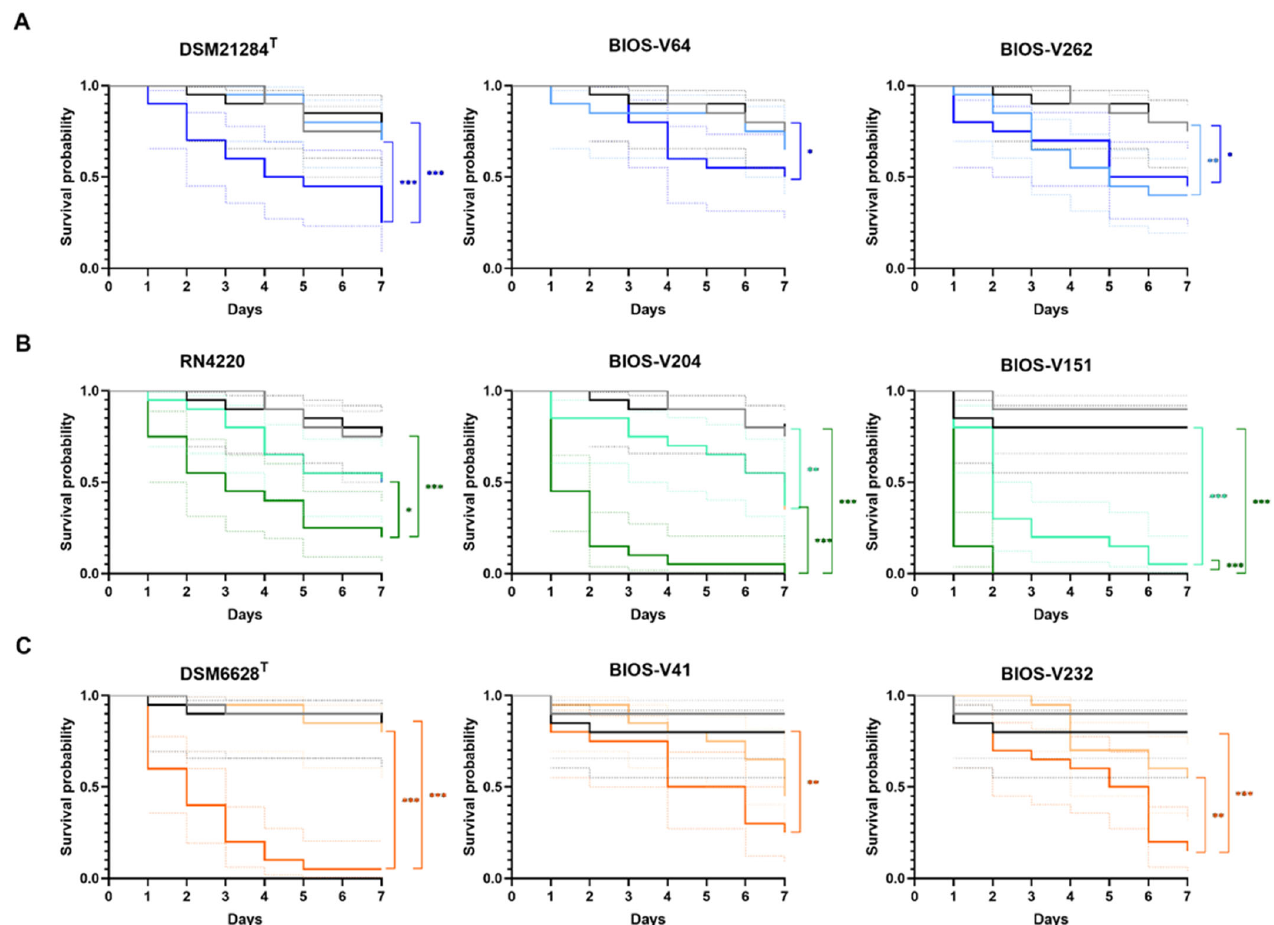
Figure 3. Kaplan–Meier survival analysis of G. mellonella infected with reference strains and biofilm-producing S. pseudintermedius ( A ), S. aureus ( B ) and S. coagulans ( C ) strains representative of the main clonal lineages causing animal pyoderma. Grey line: “no manipulation” control group; black line: “PBS” control group; light colors: 1 × 10 5 CFU/larva; dark colors: 1 × 10 7 CFU/larva. The colored dotted lines indicate the 95% confidence interval for the corresponding survival